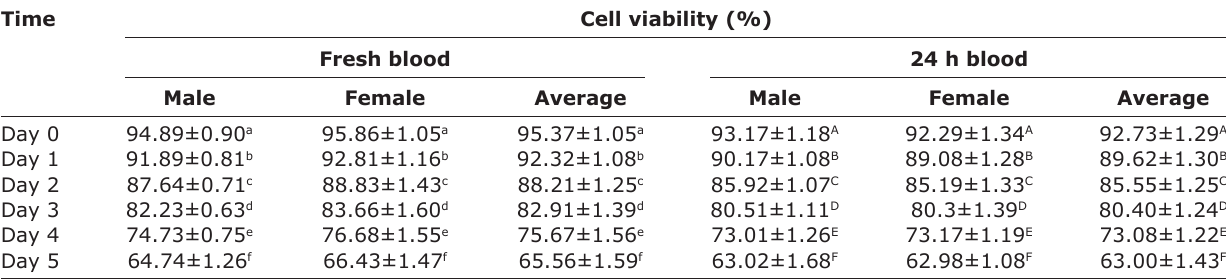
Table-3: The viability of peripheral blood mononuclear cells isolated from fresh and 24 h blood samples from Betong chickens (n=12).